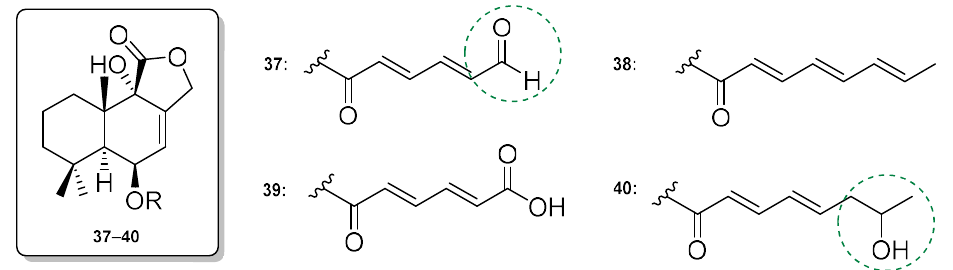
Figure 10. Cytotoxic drimanes from Aspergillus ustus against L5178Y-, PC-12-, A549-, HL-60-, and HeLa cells